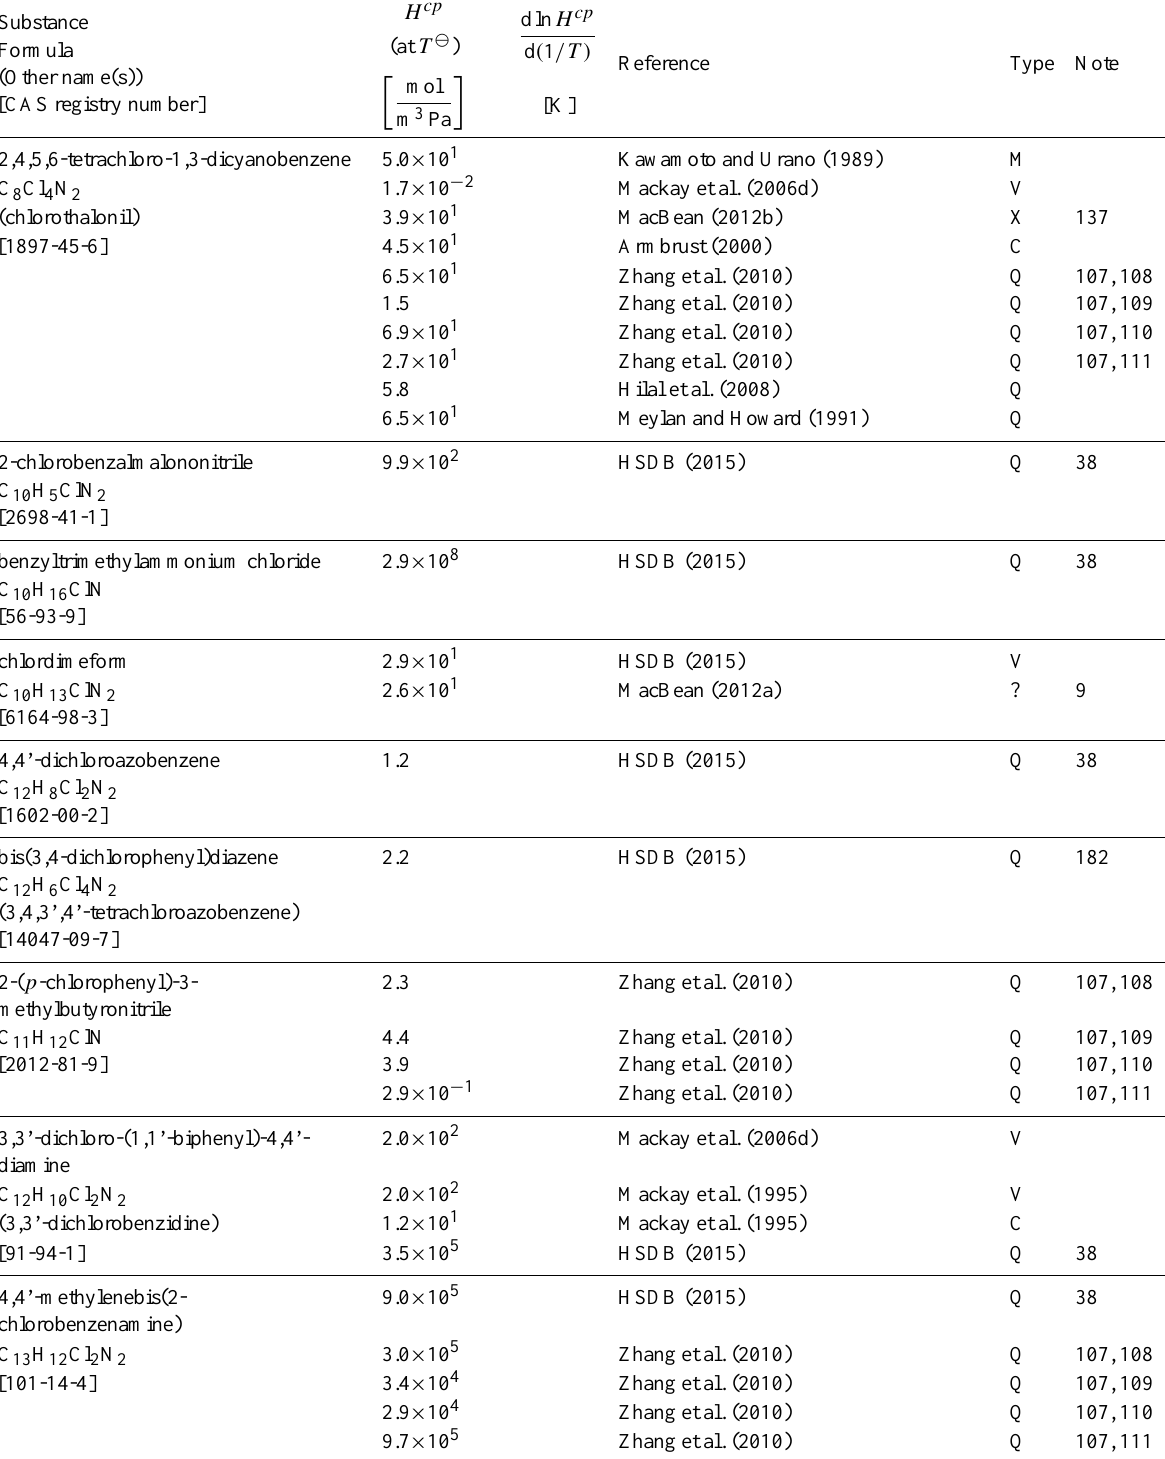
Table 6: Henry’s law constants for water as solvent